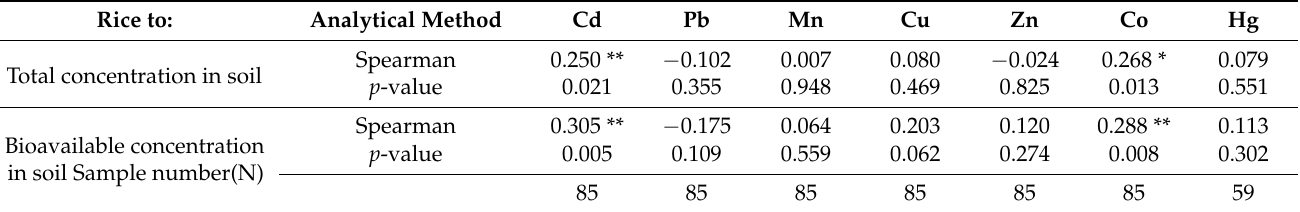
beween available concentration and the content in rice (Table 2); For Zn, Pb, Cu, Hg and in rice, the same on the available concentration to the content in rice ( p > 0.05). Table 2. Correlation analysis between PTEs concentrations in soil (total and bioavailable) and in rice. Rice to: